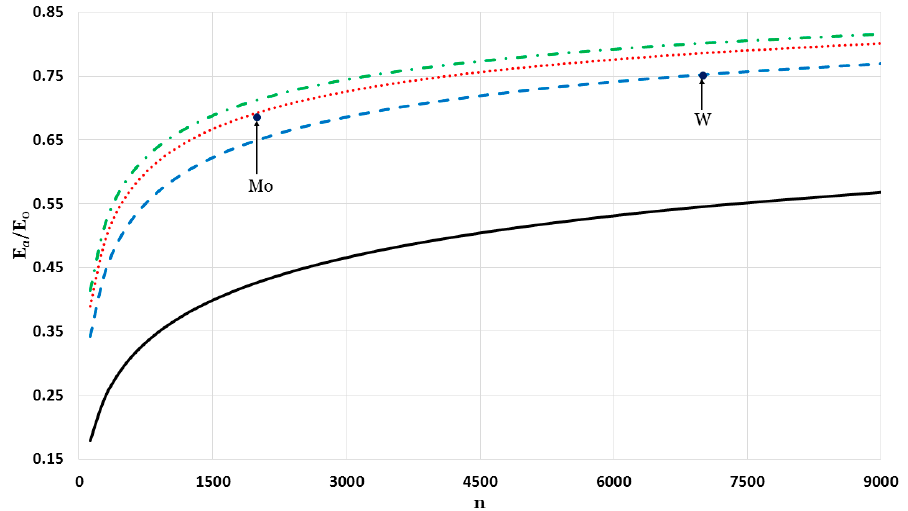
Figure 6. The variation of the relative cohesive energy of nanoparticles in a face-centered cubic structure as function of the number of atoms for (cid:2009) = 2 and different values of (cid:1865) : 2 (black solid line), 3 (blue dashed line), 4 (red dotted line), and 5 (green dashed-dotted line). The experimental values [23,24] are denoted by dark blue circles. Table 1. The relative cohesive energy of nanoparticles in a face-centered cubic structure includes (cid:1866) = 2000 and 7000 atoms for different values of (cid:1865) and (cid:2009) .